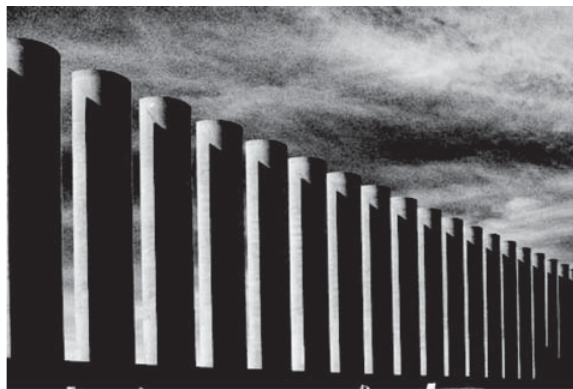
Fig. 7. Windscreen Calandkanaal – Th e Port of Rotterdam